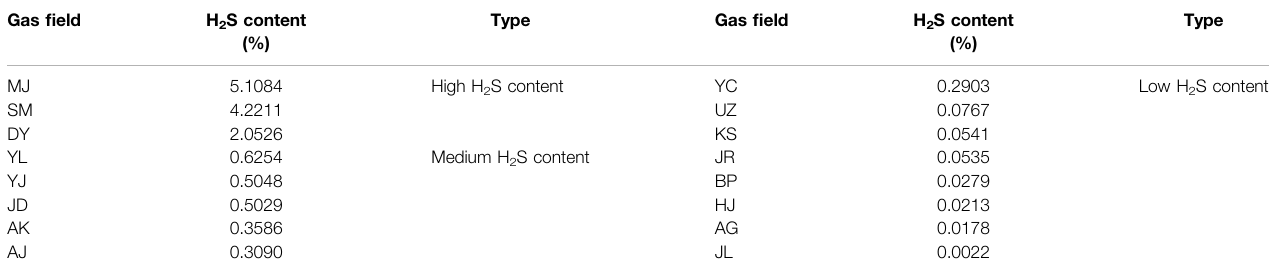
TABLE 1 | H 2 S content of different gas fi elds.